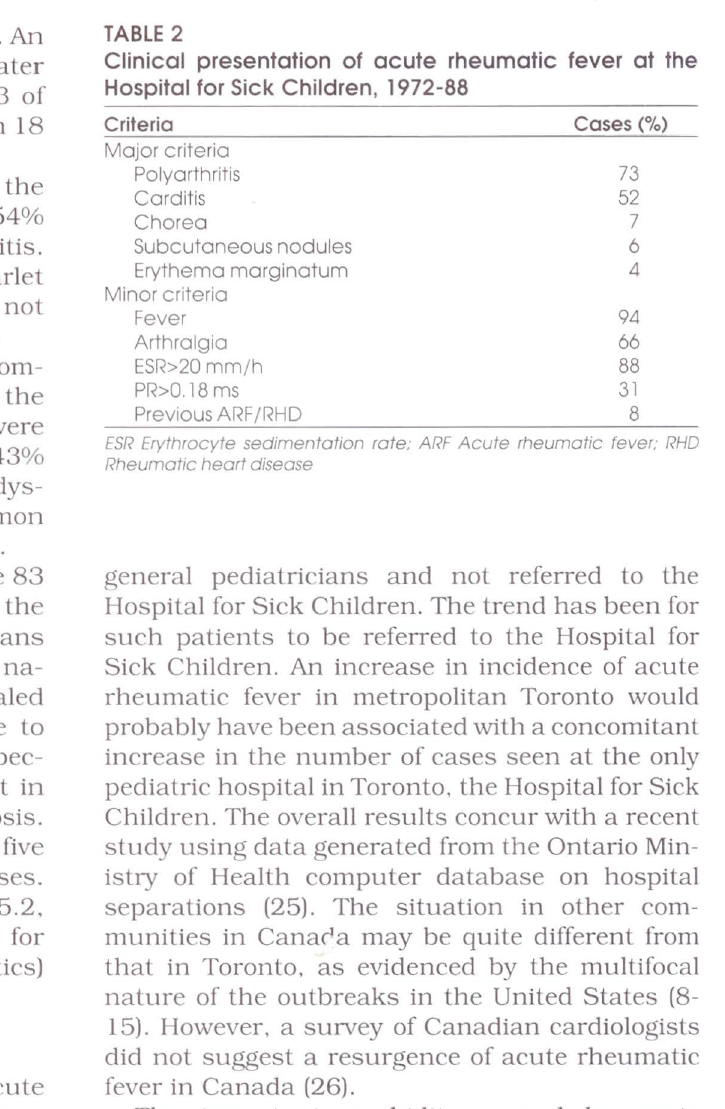
Clinical presentation of acute rheumatic fever at the Hospital for Sick Children,